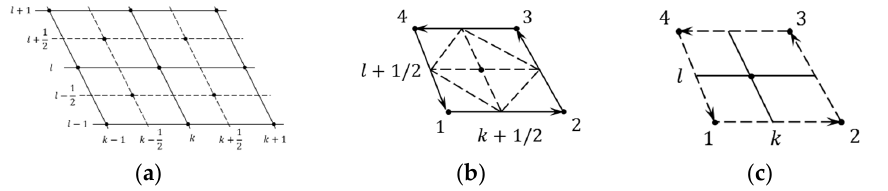
Figure A2. Difference grid and cells in a 2D domain: ( a )—difference grid; ( b )—cell centered at the point ( x k + 1/2 , y l + 1/2 ) ; ( c )—cell centered at the point ( x k , y l )